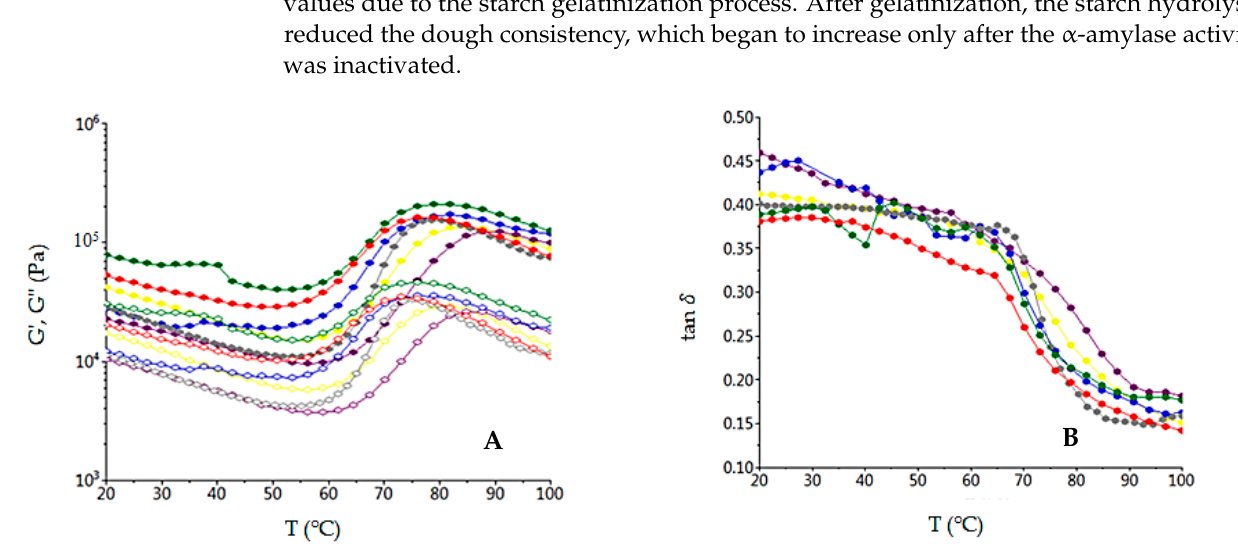
Figure 1. Evaluation with frequency of G’ (open symbols), G” (solid symbols) ( A ) and tan δ ( B ) for the samples with differ- ent levels (- ● -0%; - ● -5%; - ● -10%; - ● -15%; - ● -20%; - ● -25%) of germinated bean flour additions.